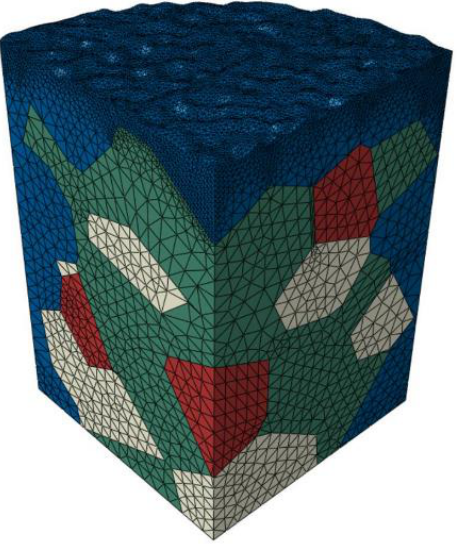
Figure 3. Three different grain orientations with the grain size of 50 µ m.